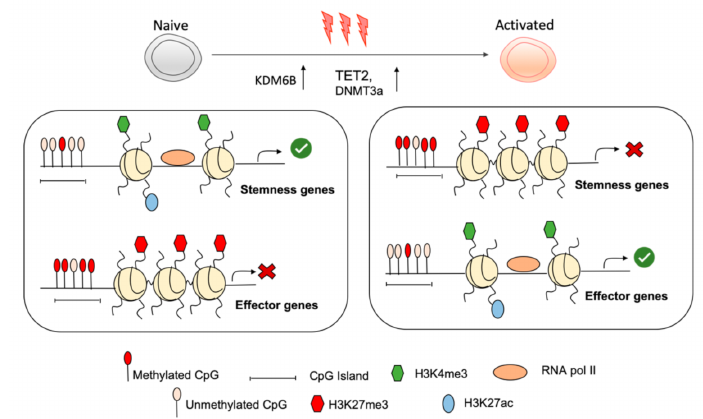
Figure 1. Epigenetic reprogramming within stemness and e ff ector loci of naïve CD8 + T cells enables active maintenance of the naïve state and rapid shutdown of naïve programming during CD8 + T cell activation. Within naïve CD8 + T cells, stemness gene loci exhibit a permissive chromatin structure with deposition of H3K4me3, H3K27ac, and unmethylated CpG island, which allows their transcription while key e ff ector gene loci are repressed by repressive histone modification such as H3K27me3 and H3K9me3 and methylation of CpG islands. During activation, stemness genes are shut down by activity of DNA methyltransferase 3a (DNMT3a) and repressive histone modifications. Chromatin remodelling within e ff ector loci permits their appropriate expression by permissive histone